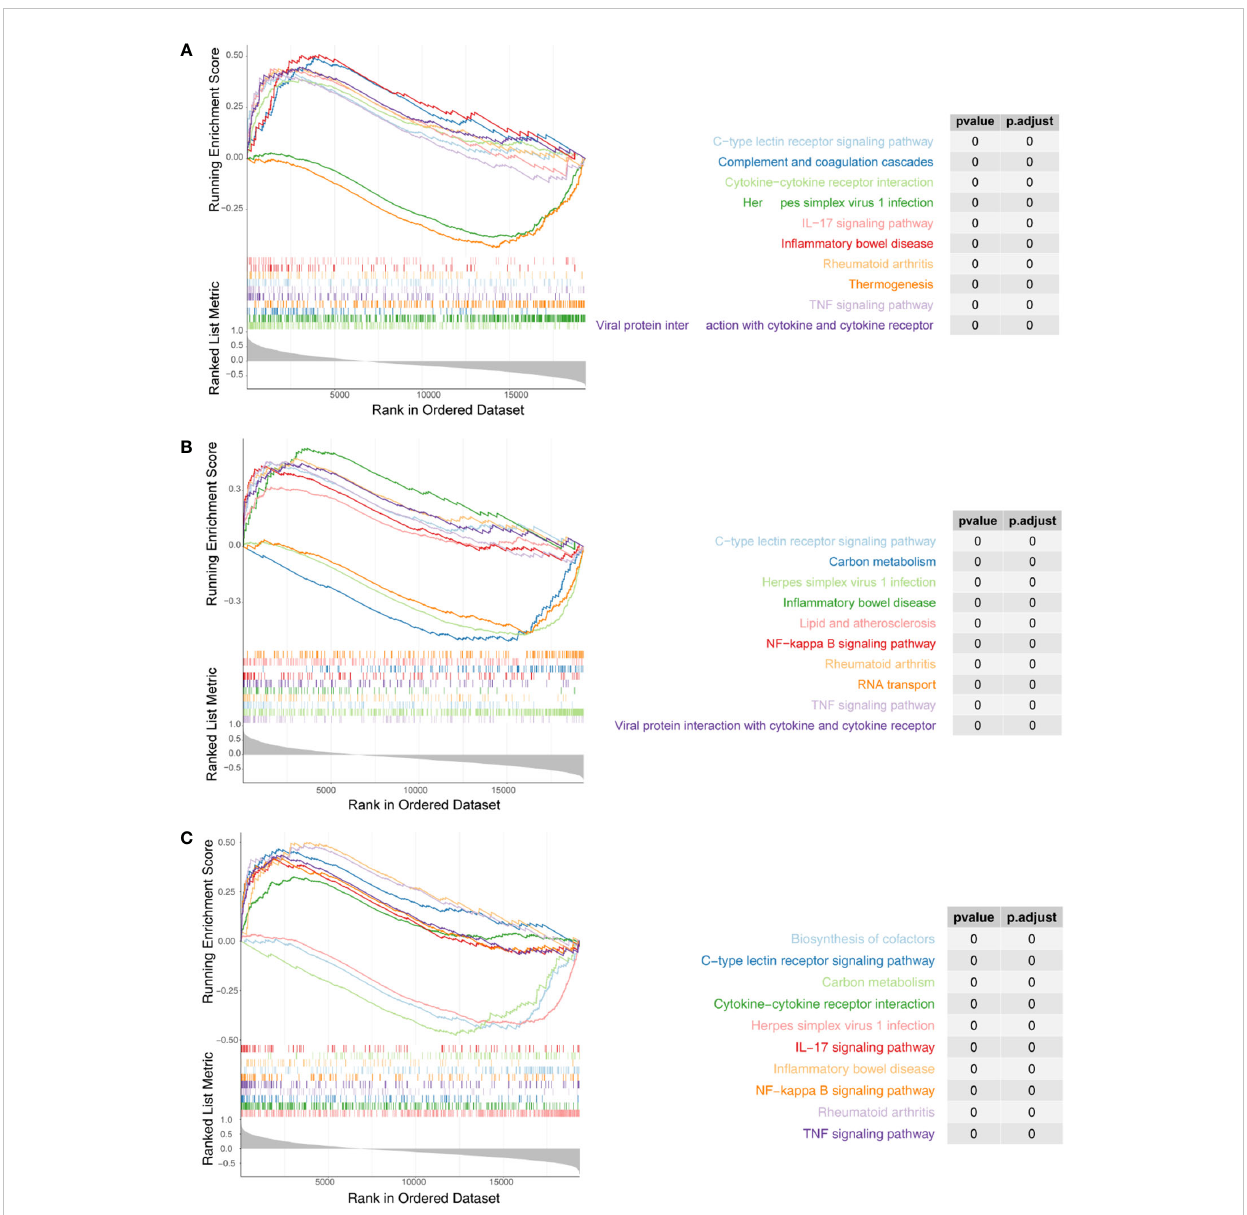
FIGURE 5 Single-sample Gene set enrichment analysis (ssGSEA) of three biomarkers. (A) Enrichment analysis of IRF1 single gene GSEA. (B) Enrichment analysis of NFKBIA ssGSEA. (C) Enrichment analysis of ssGSEA in YRDC. The screening criteria were set as |normalized enrichment score (NES)| ≥ 1, NOM p- val < 0.05, FDR q-val <